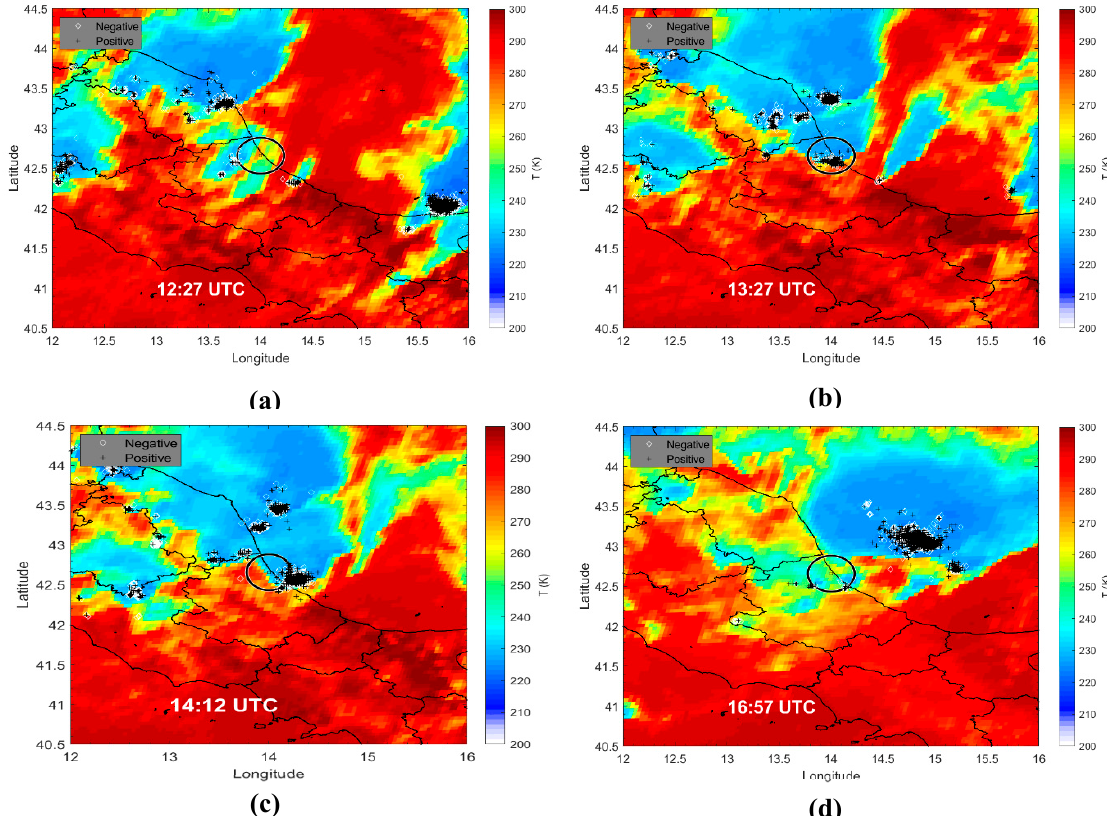
Figure 7. Time evolution of the convective storm, which interested Pineto on 2nd September 2018. The panels ( a ) to ( d ) report the TB as measured by SEVIRI channel 9 and the positive (black crosses) and negative (white diamonds) strokes, as recorded by LINET network at ( a ) 12:27, ( b ) 13:27, ( c ) 14:12, and ( d ) 16:57 UTS, respectively. The black circle is centred in correspondence of GPS antenna and identifies the area where its measurements are consistent (i.e., around a 25-km radius).